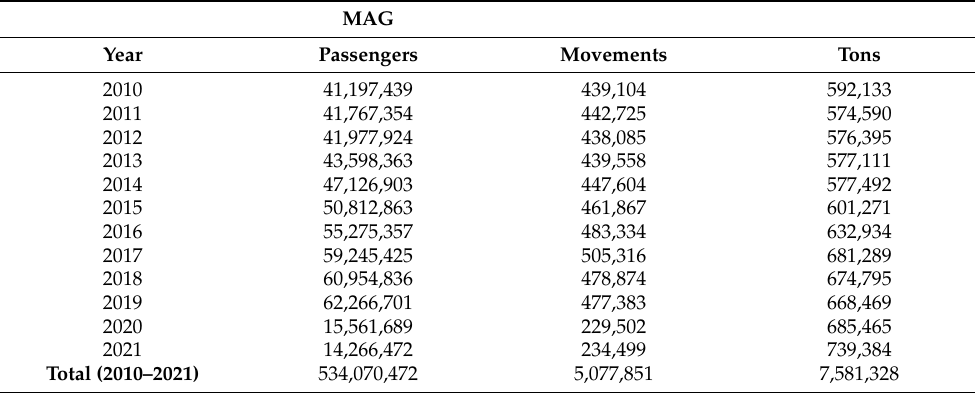
Table 2. AENA passenger, aircraft, and cargo movements